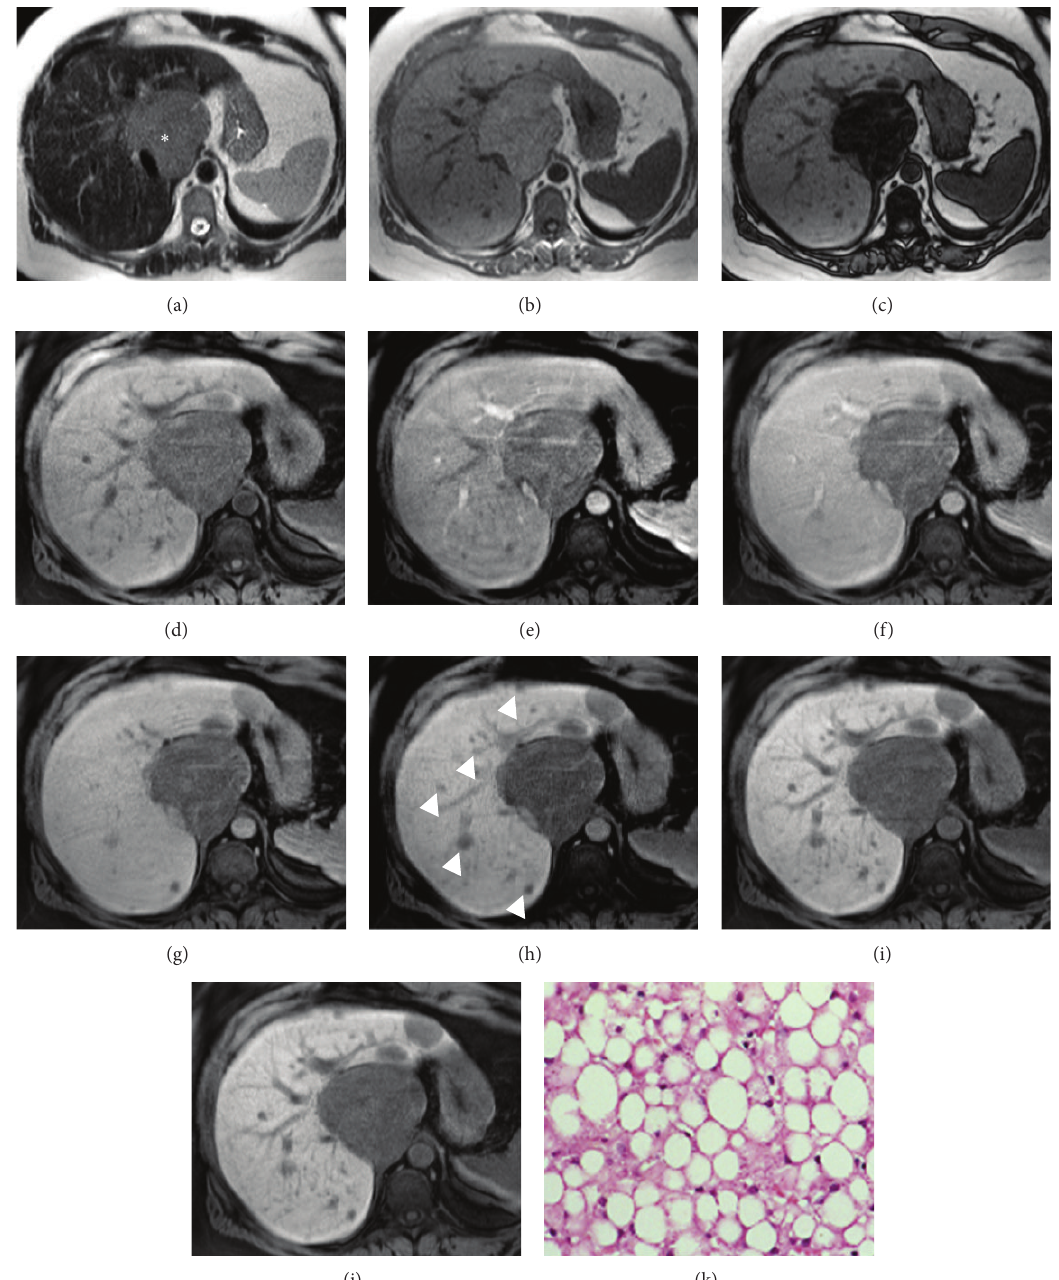
Figure 4: HNF-1 𝛼 -mutated adenomas. (a) Axial T2w images without fat suppression. In S I and S II multiple slightly homogeneous hyperintense lesions (asterisk indicates the largest nodule biopsied). (b-c) T1w in- and out-phased images. Due to significant intralesional presenceoffattissue,thenodulesshowsignaldropwithvariabledegreeinc.(d–h)IndynamicevaluationafterGd-EOB-DTPAadministration the nodules show poor enhancement. In (h), after 5 󸀠 the nodules are more hypointense; other lesions may be detected in both hepatic lobes (arrowheads). (i-j) In hepatobiliary phases after 10 󸀠 (i) and 20 󸀠 (j), all adenomas are hypointense relative to adjacent liver parenchyma. (k) Histology confirms presence of fat-rich